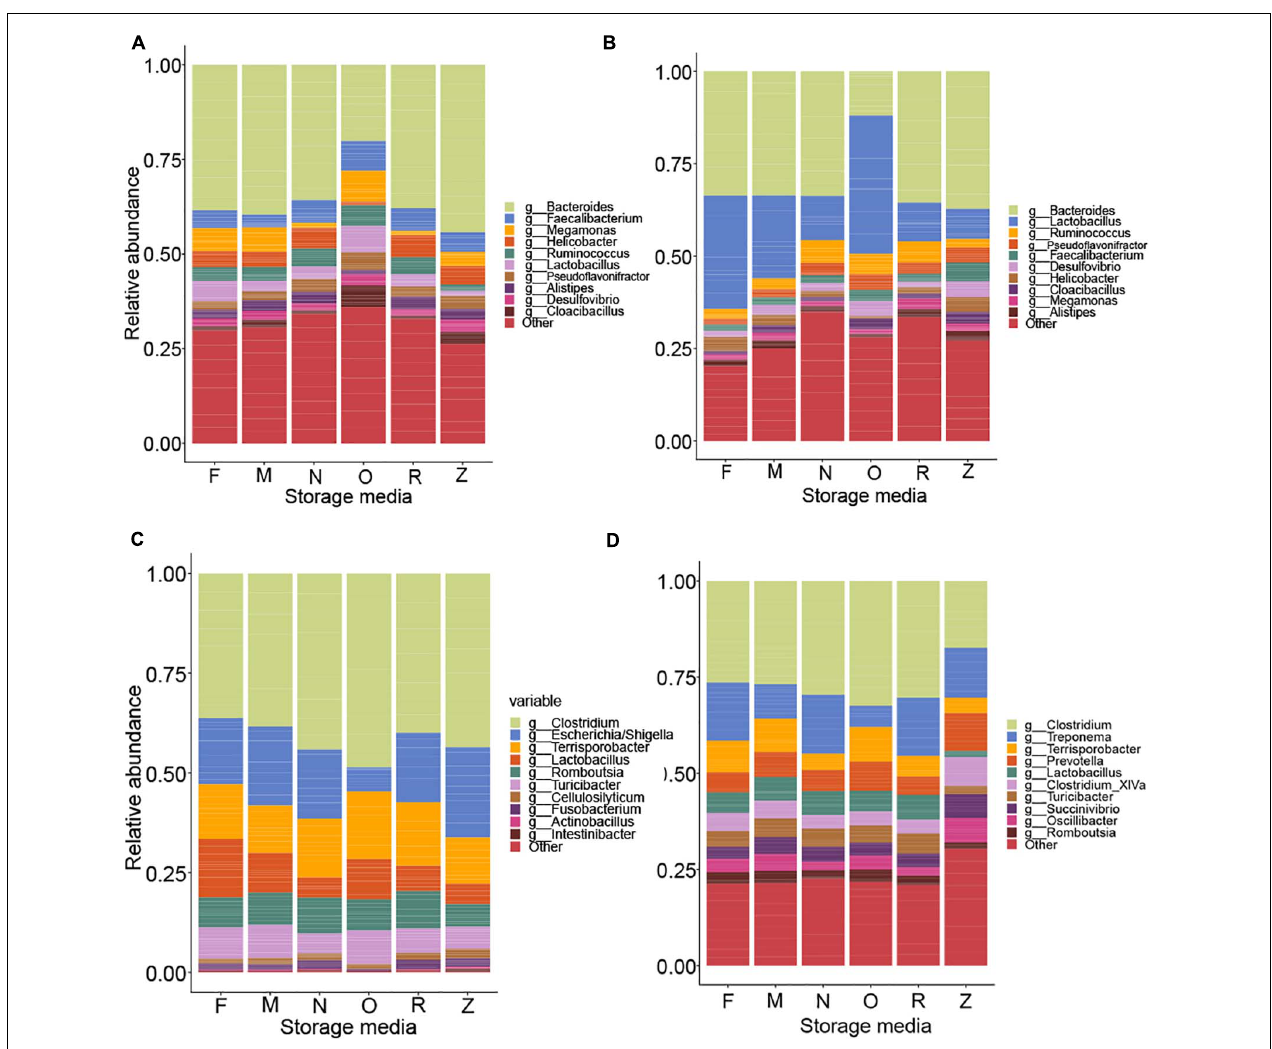
FIGURE 8 | Comparisons of different storage media on 16S rRNA gene sequencing of livestock samples. Within the relative abundance analysis, the top 10 genera are shown for comparison for pooled samples collected from the chicken cecum (A) , chicken feces (B) , pig ileum (C) , and pig feces (D)